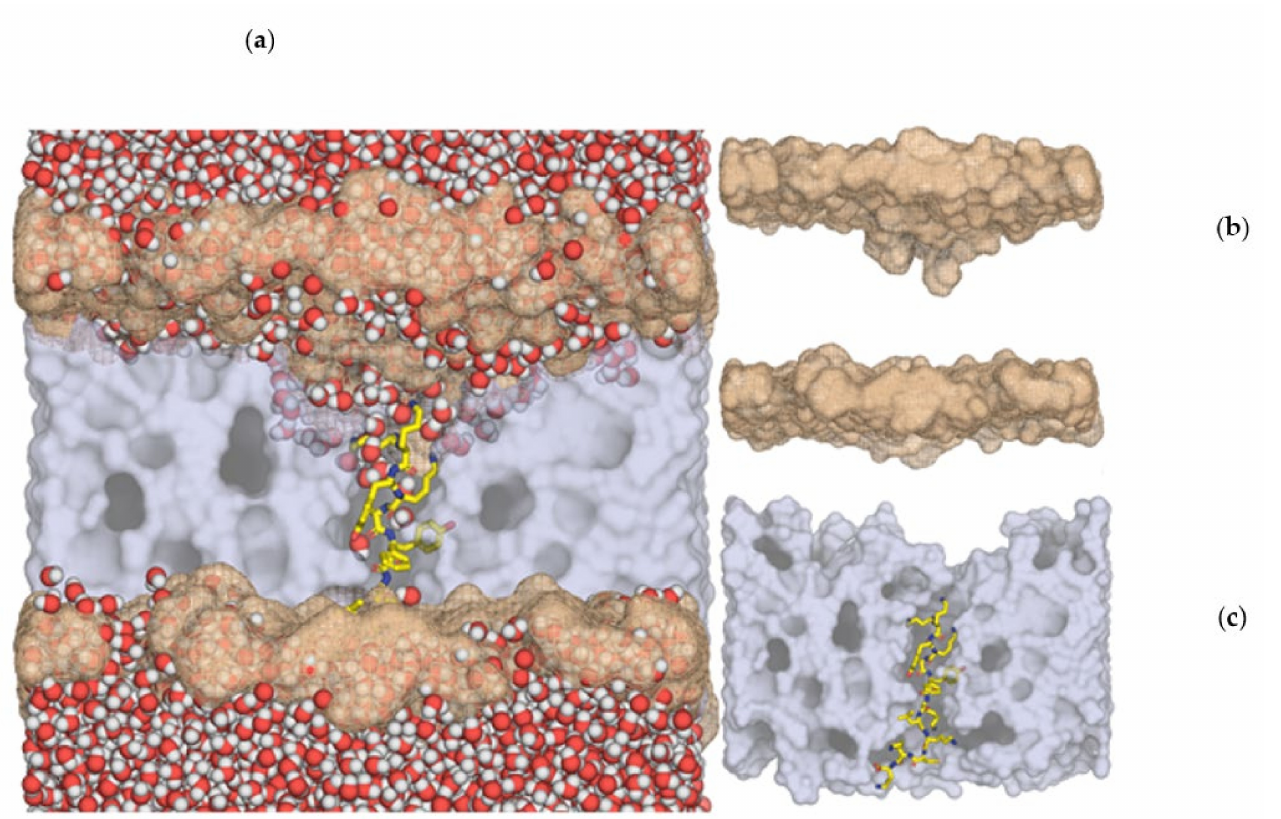
Figure 5. p-Acl peptide interaction with the DOPS membrane bilayer (one-half of the membrane and water molecules were removed for better visualization; the inner hydrophobic core of the membrane is shown in grey; the positions of the phosphorus atoms in the headgroups are shown in salmon). Left ( a ): a large deformation in the position of the phospholipid headgroups is visible, with the phosphate moieties penetrating deeply into the membrane core, more pronounced in the upper leaflet; in addition, the penetration of water molecules deep into the membrane is visible, confirming that the peptide induces a membrane-permeabilization effect. Top-right ( b ): only membrane inner hydrophobic core and phosphorus positions are shown, for clarity; the deformation of the membrane headgroups towards the inner part of the membrane is evident. Lower-right ( c ): insertion of peptide p- Acl (stick model) into the membrane inner hydrophobic core, showing the peptide’s perfect structural fitness to span the whole width of the